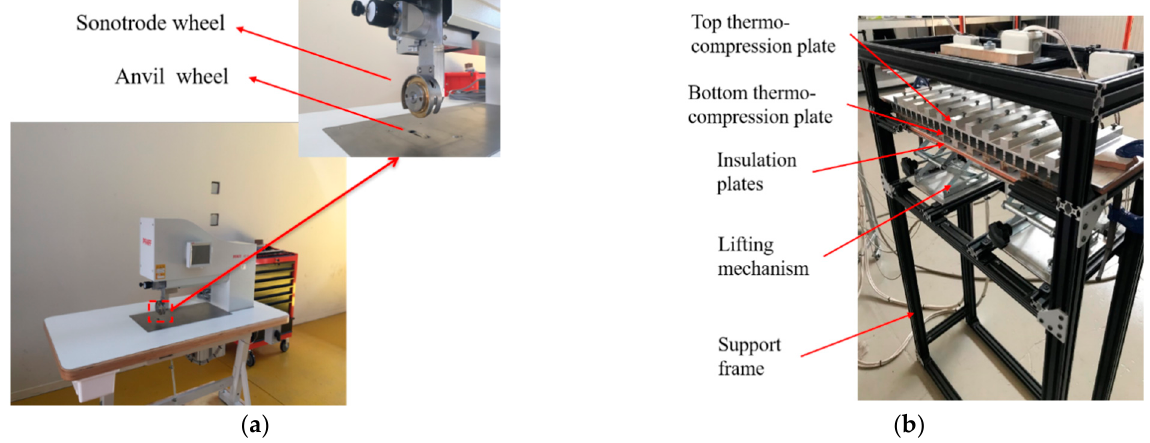
Figure 2. ( a ) Ultrasonic welding module. ( b ) Thermo-compression module with indications of all parts.